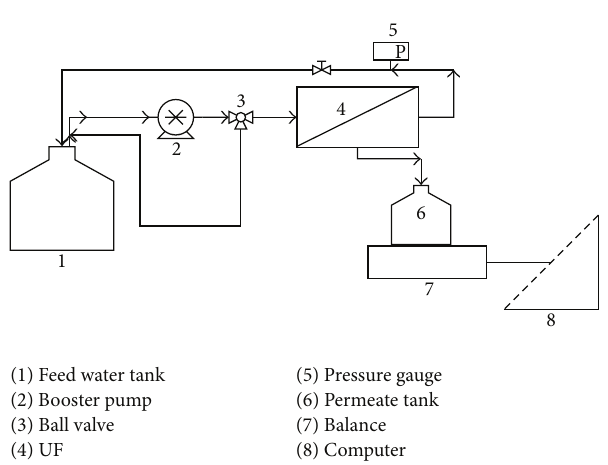
Figure 2: Diagram of the UF system.